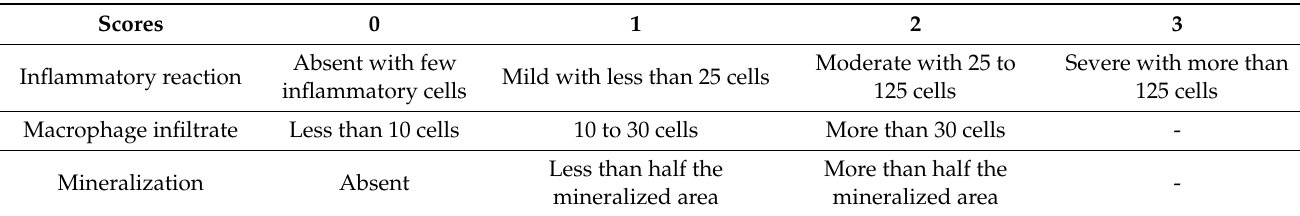
Table 2. Score system used to evaluate histopathologic features of the specimens. Scores 0 1 Inflammatory